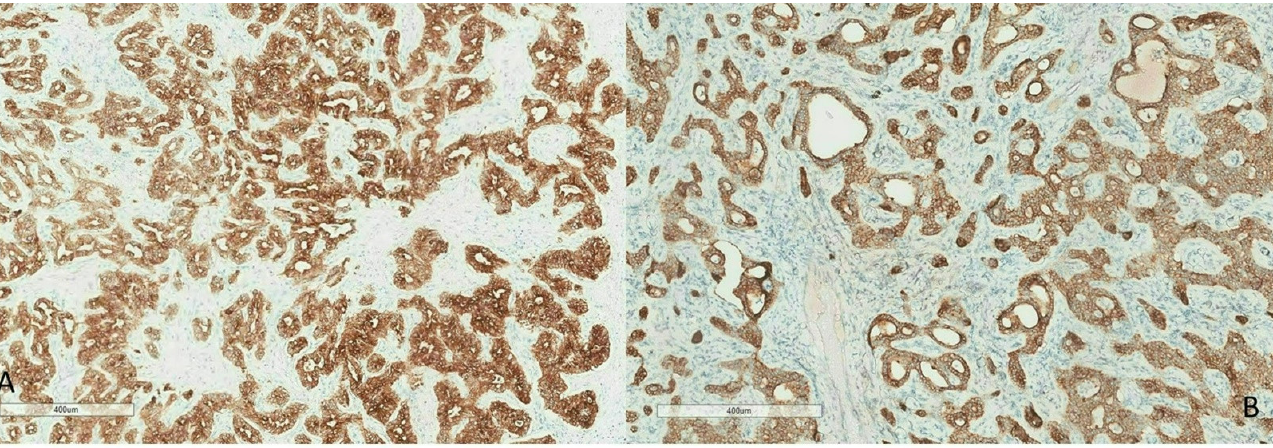
Figure 6. Immunohistochemistry of CK7 ( A ) and CK19 ( B ) showing strong cytoplasmic staining (brown) of an intrahepatic cholangiocarcinoma.